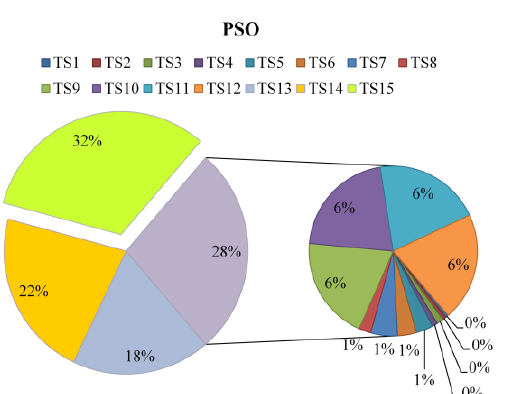
Table 4. Comparison of RT values